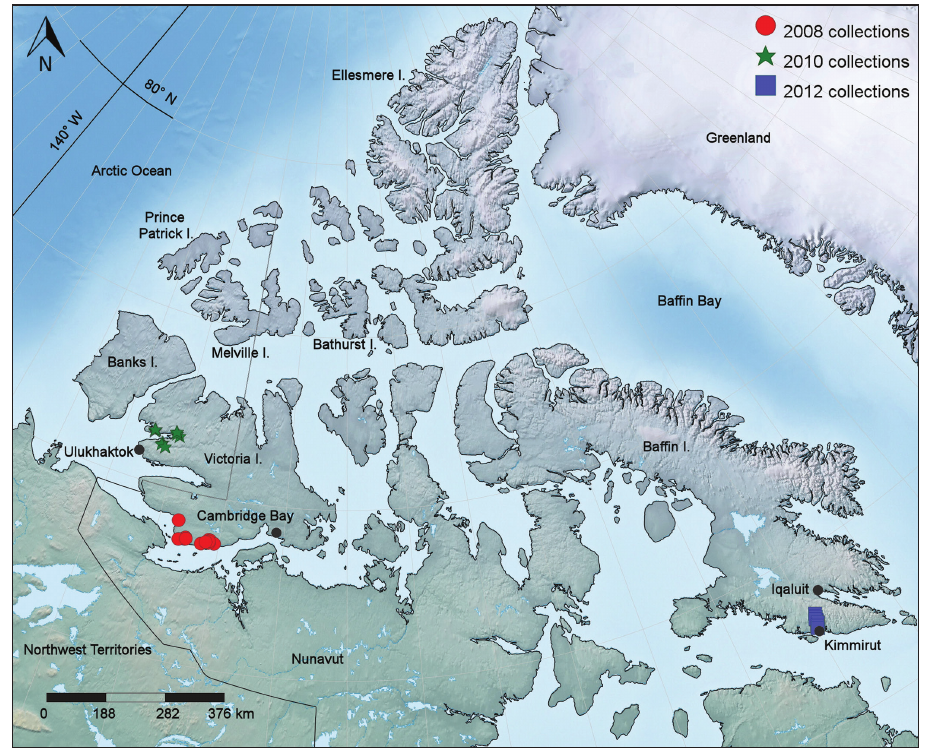
Figure 1. Map of the Canadian Arctic Archipelago showing 2008, 2010 and 2012 collection sites for new vascular plant